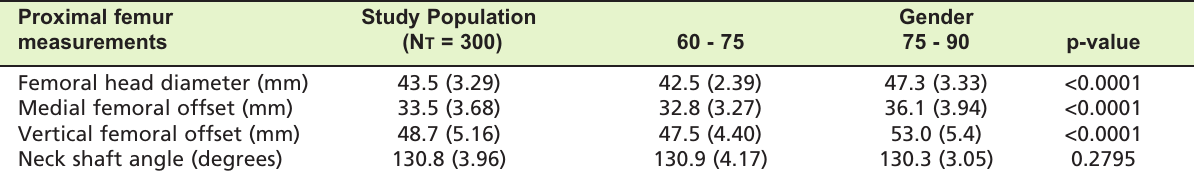
Morphological measurements – comparing age groups Table II: